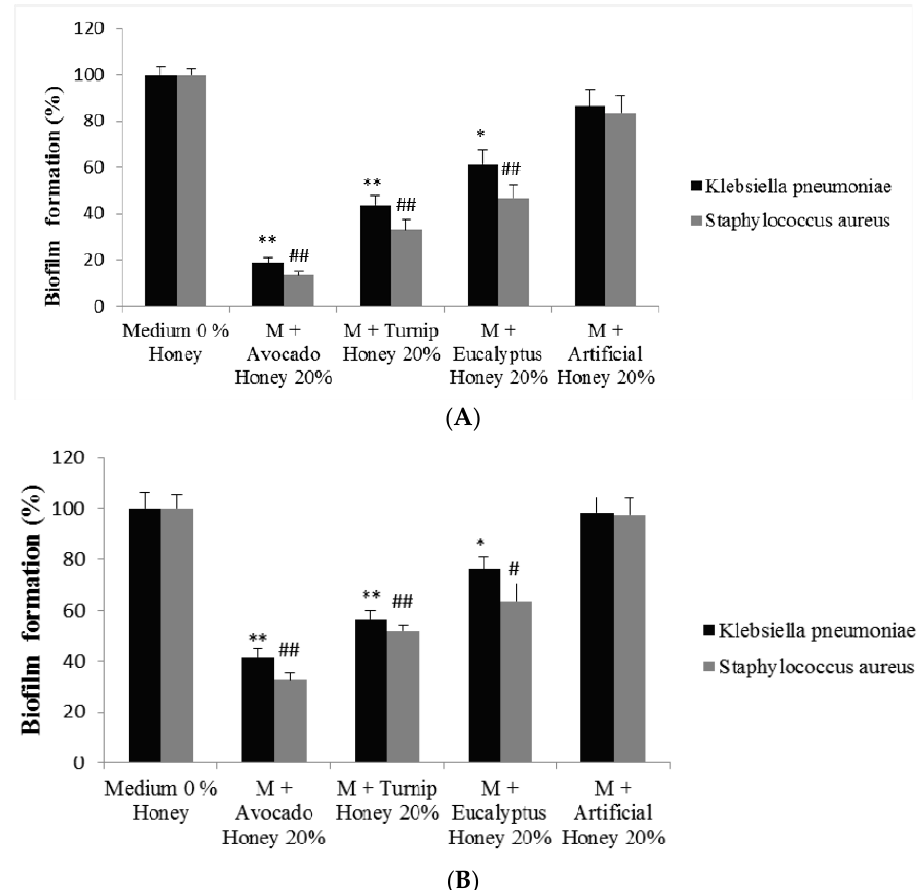
Figure 3. Effectiveness of the three monofloral honeys in inhibiting biofilm formation ( A ) and removing preformed biofilm ( B ) in Staphylococcus aureus and Klebsiella pneumoniae bacteria. Columns belonging to the same set of data with different symbols are significantly different when compared to control (Medium 0% Honey). * p < 0.05, # p < 0.05 and ** p < 0.05, ## p < 0.01.